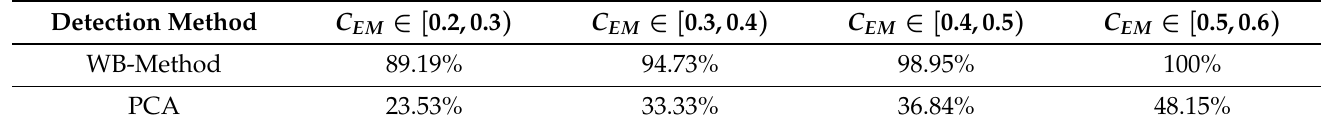
Figure 8. Feature point map of the two methods. Table 3. Recall rate of leak detection in different C EM .